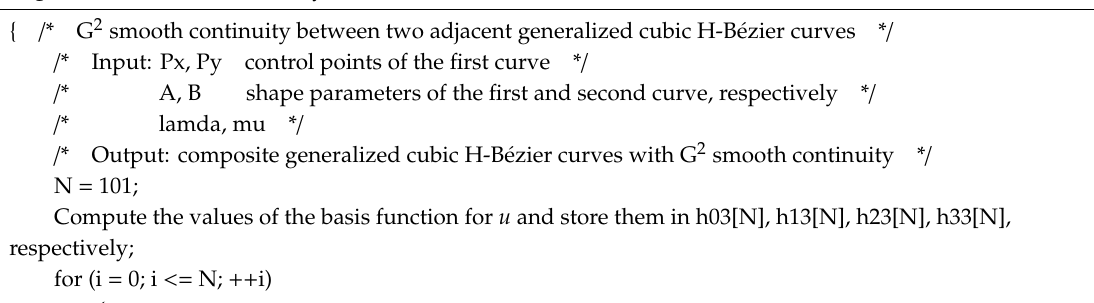
Algorithm 1. CurveJoint(Px, Py, A, B, lamda, mu) { / * G 2 smooth continuity between two adjacent generalized cubic H-B é zier curves *